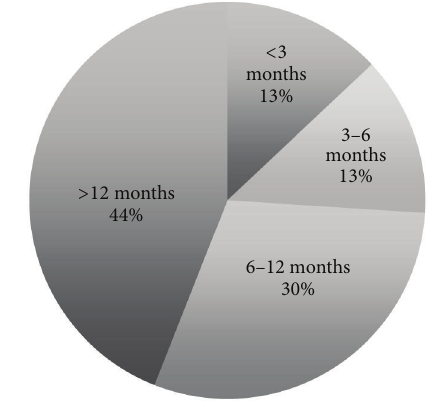
Figure 5: Lapse of time wearing MEW when the emergency